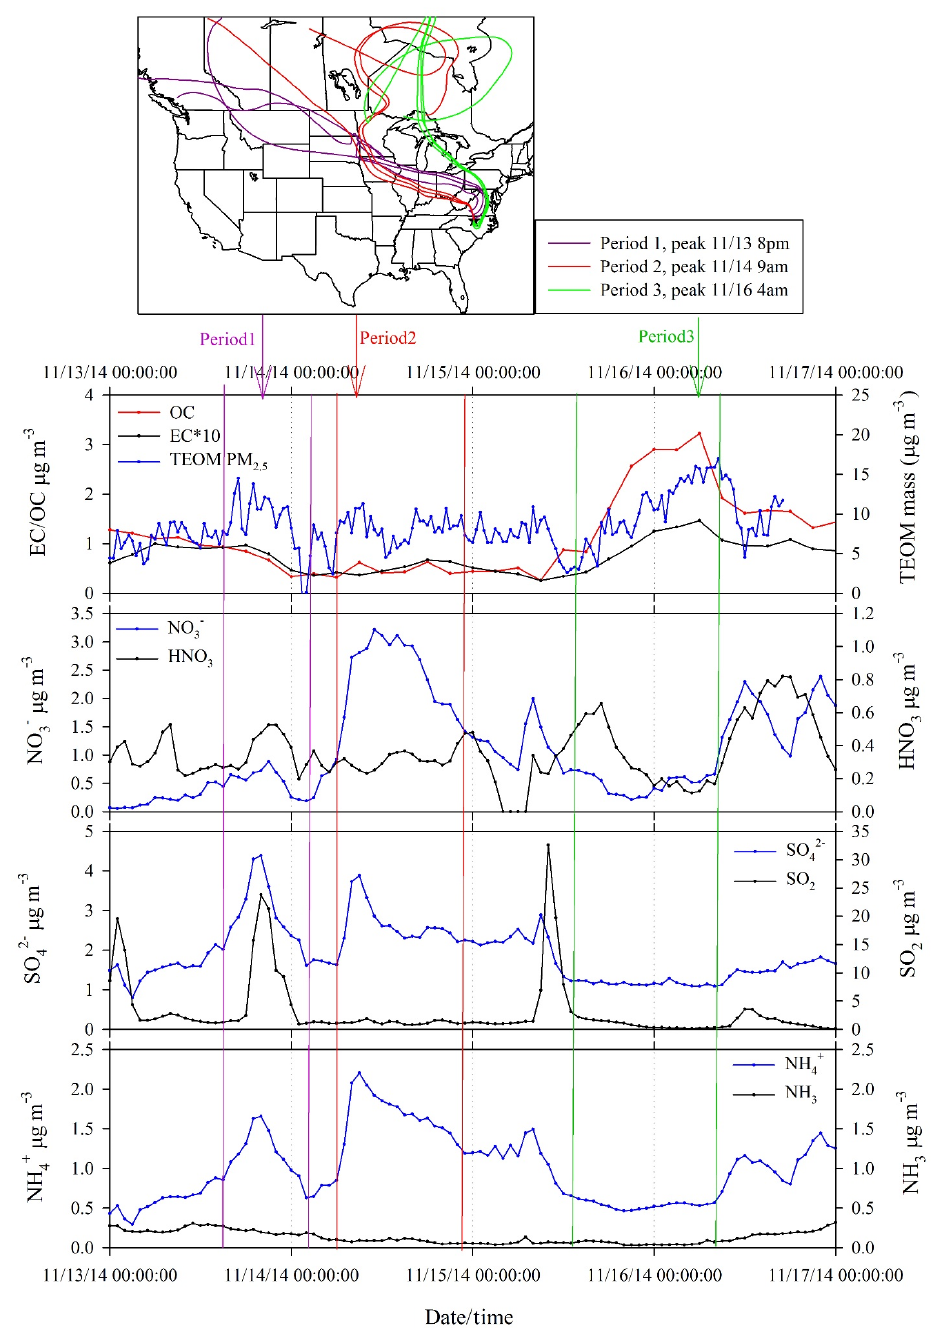
Figure 6. High-concentration periods observed during mid-November 2014. Period 1: highest SO 2 − Period 3: highest OC. Corresponding back trajectories (arrival at 500AGL, backwards for 168h) of individual period peaks ( ± 2h) are also